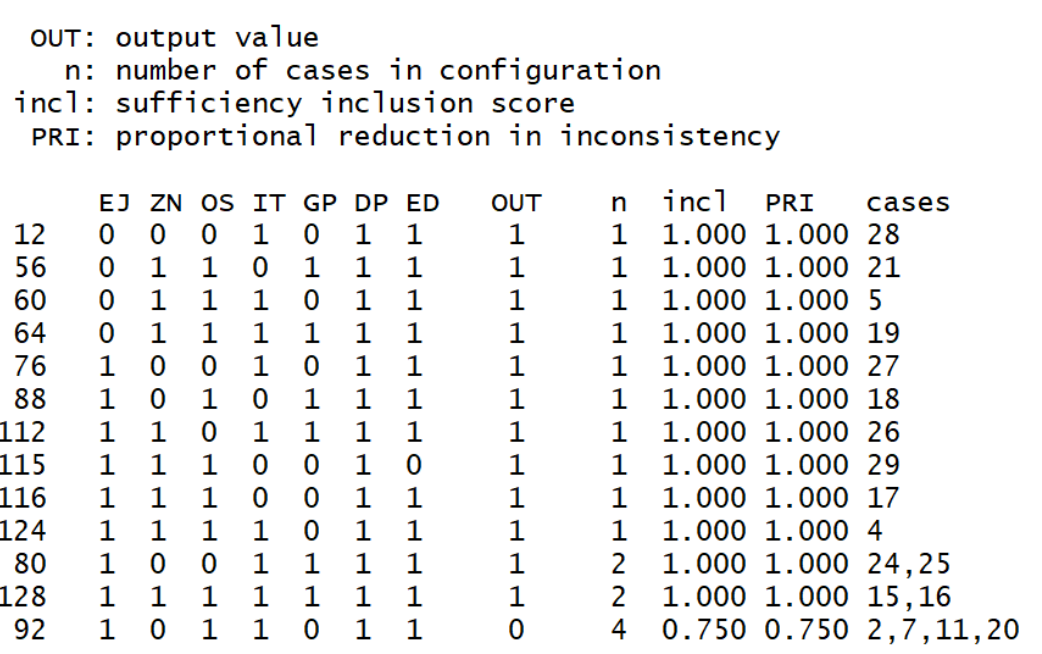
Figure 3. Fragment of the truth table.